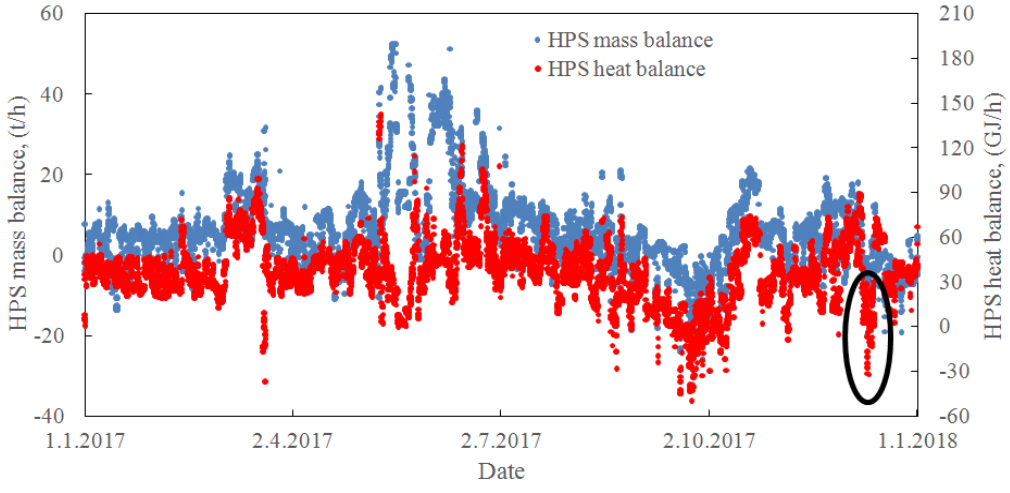
Figure 8. A difference between the amount of steam supplied and consumed within the HPS network during the year 2017.